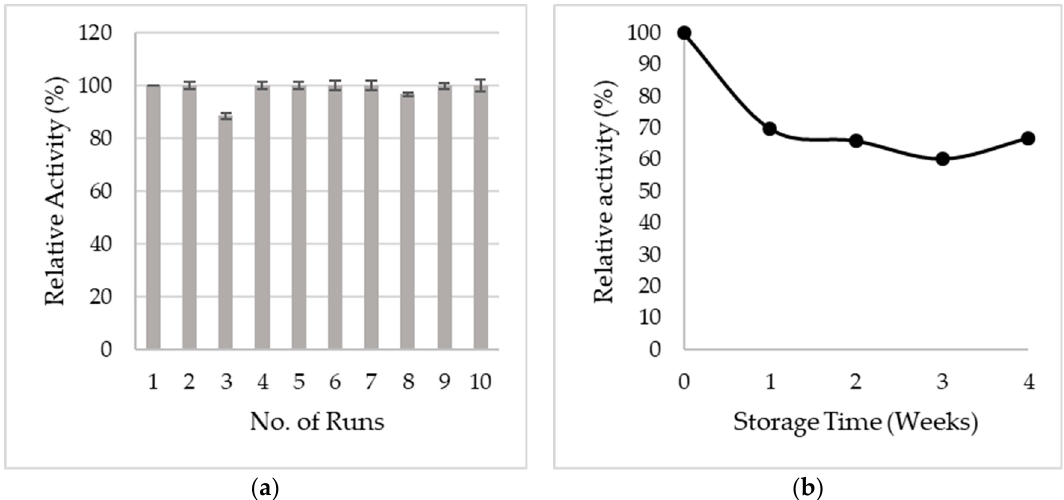
Figure 7. ( a ) Reusability and ( b ) storage stability of GOx-magnetic CNCs. (Error bar represents the standard error of triplicate data). Table 2. Comparison of di ff erent immobilization support on the reusability of immobilized GOx. Immobilization